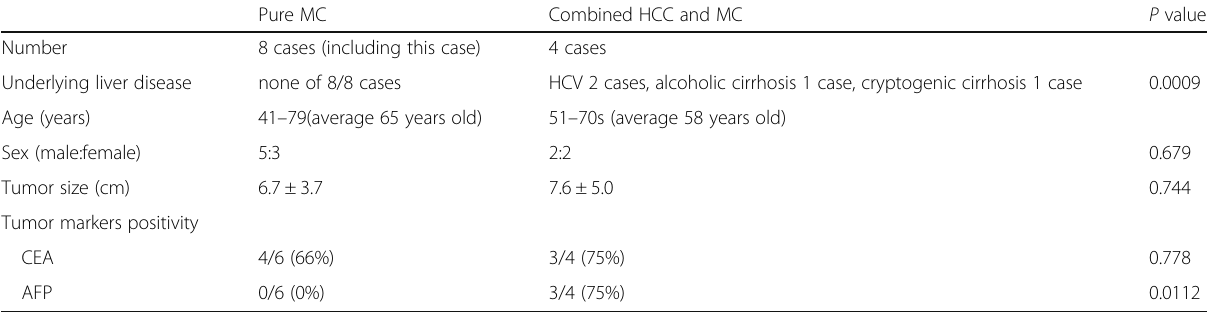
Table 1 Summary of clinicopathological features in reported cases of mucinous cholangiocarcinoma, including the current case Pure MC